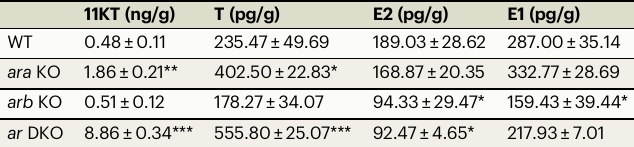
ar DKO 8.86±0.34*** 555.80±25.07*** 92.47±4.65* 217.93±7.01 Data aremean±s.e., n =3.* P <0.05,** P <0.01,*** P <0.001, (two-sided Dunnett ’ s multiple comparisontest,11KT:WTvs ara KO,estimate±s.e.=1.373±0.307, t =4.474, P =0.00524;WTvs ar DKO, estimate±s.e.=8.38±0.307, t =27.3, P <0.001; T: WT vs ara KO, estimate±s.e.= 167.03±48.89, t =3.417, P =0.0225;WTvs ar DKO, estimate±s.e.=320.33±48.89, t =6.553, P <0.001;E2:WTvs arb KO,estimate±s.e.= − 94.7±32.59, t = − 2.906, P =0.0479;WTvs ar DKO, estimate±s.e.= − 95.57±32.59, t = − 2.963, P =0.0442;E1: WTvs arb KO, estimate±s.e.= − 127.57 ±42.8, t = − 2.981, P =0.0431).Sourcedata,theotherstatisticaldata,andchromatogramsof11KT andT inLC/M analysis are provided as a Source Data fi le, Supplementary Table 3, andSup- plementary Fig. 15,